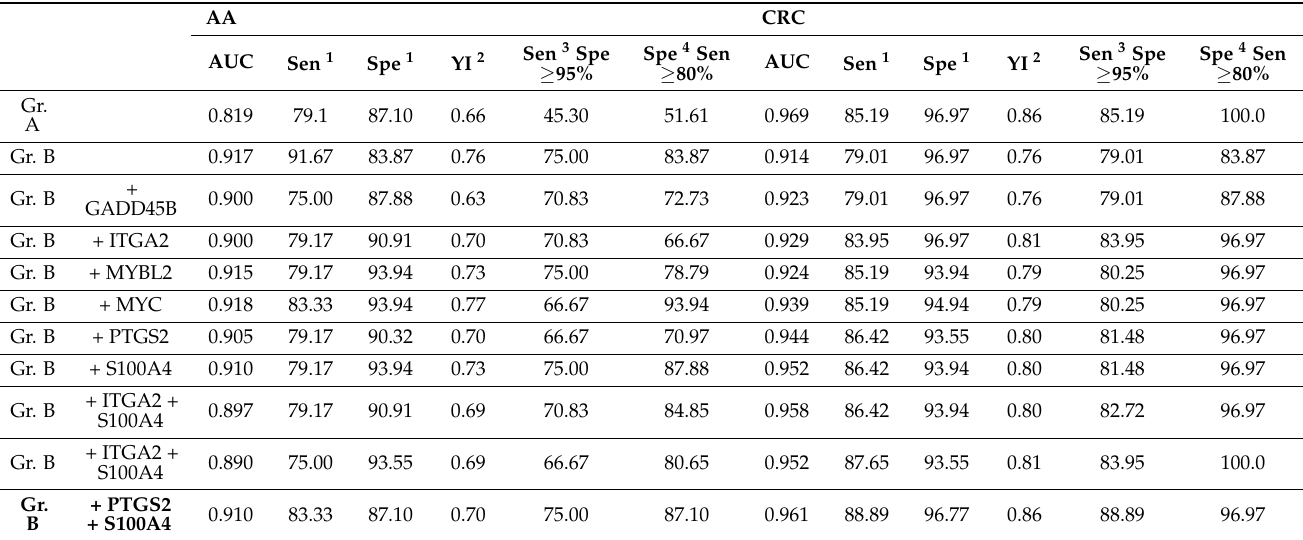
Table 2. Selection of the best combinations of